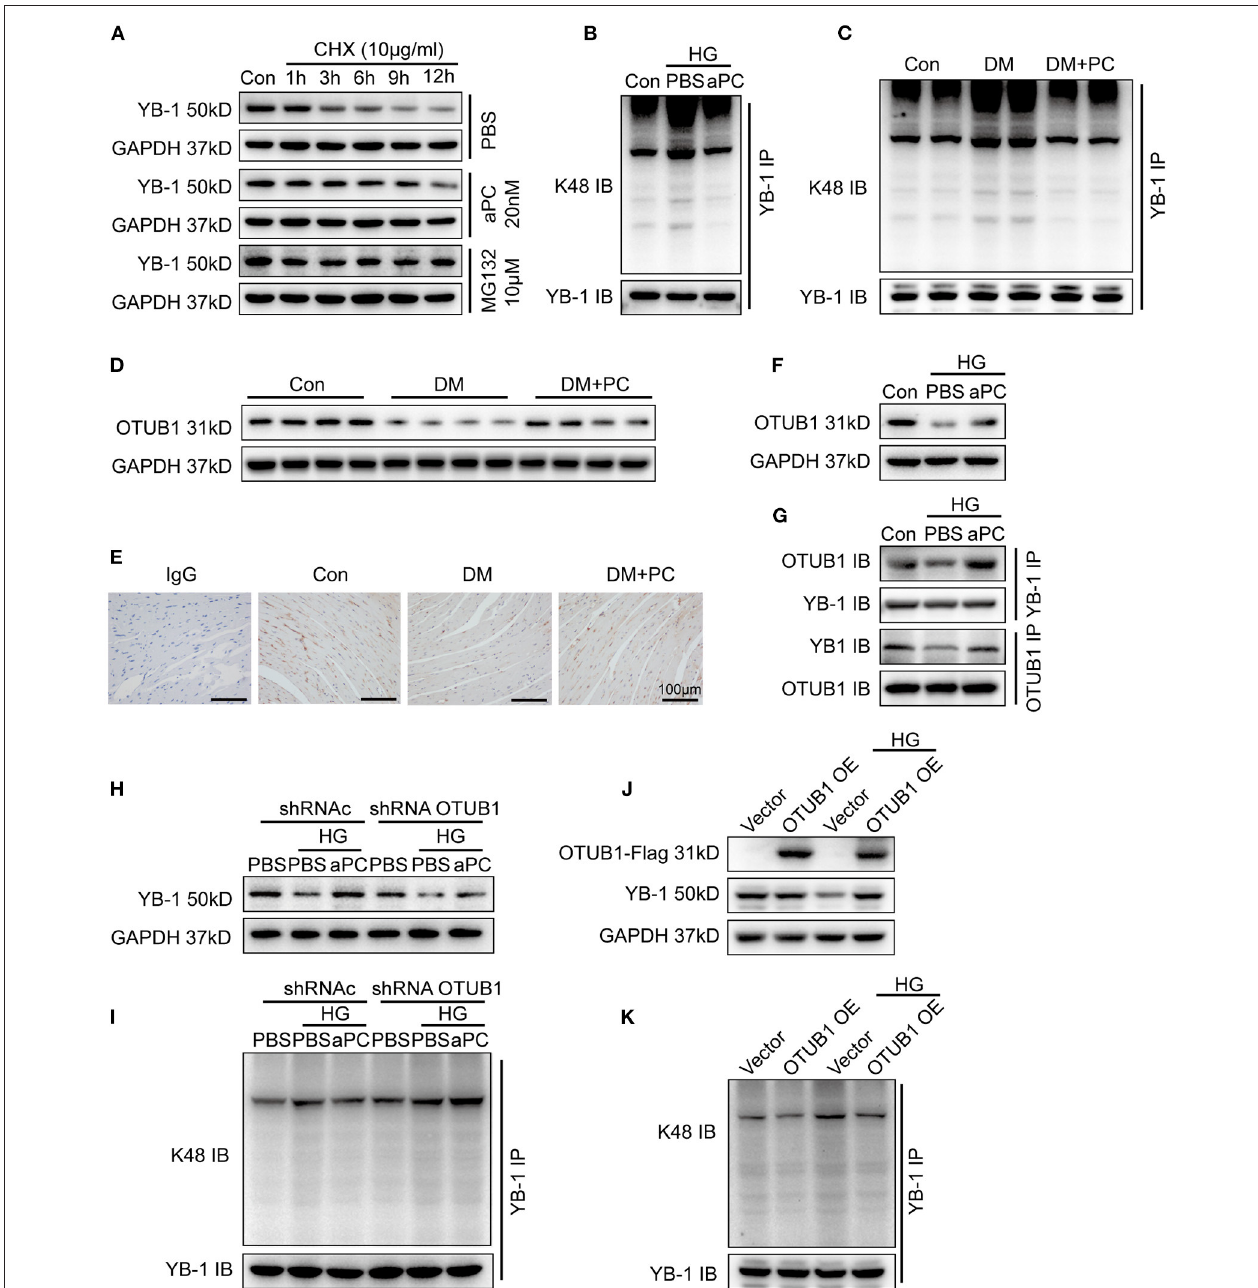
FIGURE 4 | aPC can maintain the YB-1 expression via OTUB1 dependent K48 deubiquitination. (A) After protein synthesis inhibition by CHX (10 µ g/ml) treatment, YB-1 protein stability was enhanced by pre-treatment of proteasome inhibitor MG132 (10mM) and aPC (20nM) in H9c2 cells. (B) Co-IP showed that HG can promote the K48-linked ubiquitination of YB-1 in H9c2 cells infected with GFP-labeled YB-1 overexpression adenovirus, while aPC can reverse it. Co-IP was performed with 1 µ g anti-GFP primary monoclonal antibody. (C) K48-linked ubiquitination of YB-1 in diabetic mice heart tissue with or without PC treatment. Co-IP was performed with 1 µ g anti-YB-1 monoclonal antibody. (D) Representative OTUB1 immunoblots in mice heart tissue lysates with or without PC treatment. (E) Immunohistochemistry staining showing the expression level of OTUB1 in mice heart section. Scale bar: 100 µ m. (F) Exemplary OTUB1 immunoblots in HG co-incubated H9c2 cells challenged with aPC or not. (G) H9c2 cells were infected with both GFP-labeled YB-1 overexpression adenovirus and Flag-labeled OTUB1 overexpression adenovirus. Co-IP was performed with corresponding antibodies to determine the interaction between YB-1 and OTUB1. (H) Representative immunoblots of YB-1 in H9c2 cells infected with control shRNA lentivirus or OTUB1 specific shRNA lentivirus. (I) Co-IP result showed K48-linked ubiquitination of YB-1 in OTUB1 knock down H9c2 cells. (J) Western blots of YB-1 in H9c2 cells infected with control adenovirus or OTUB1 overexpression adenovirus, stimulated with HG or not. H9c2 cellswere infected with vectorcontroladenovirusorFlag-labeled OTUB1overexpressionadenovirus.AntibodytoFlag wasusedtodetecttheexogenousoverexpressed